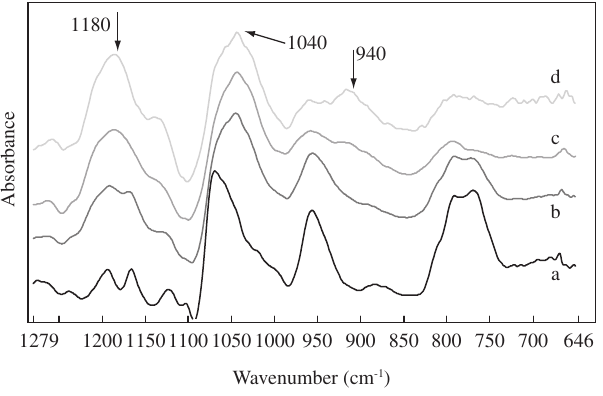
Figure 5. C1 FTIR spectra subtracted from the spectrum of PU-1: a) C1-A; b) C1-C; c) C1-D; and d) C1-F.